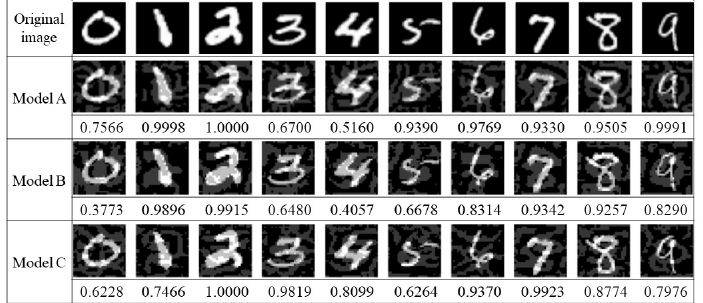
Figure 3. Visualization of the AE in targeted l 2 attack.